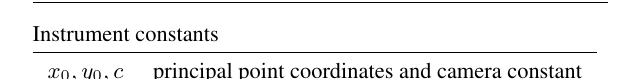
Table 1: Coordinate reference frames, parameters, observations and instrument constants.